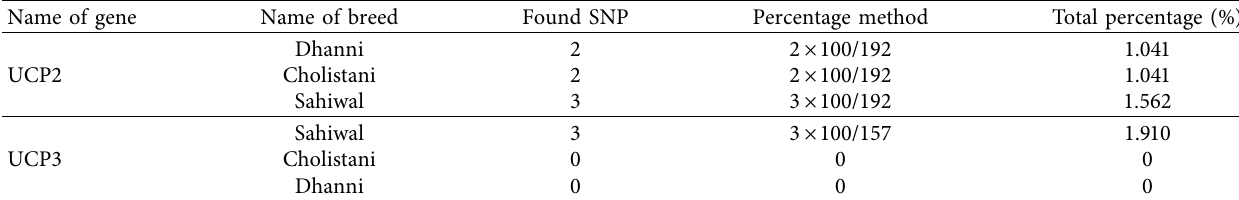
Table 2: Mutation percentage of three different cattle breeds. Name of gene